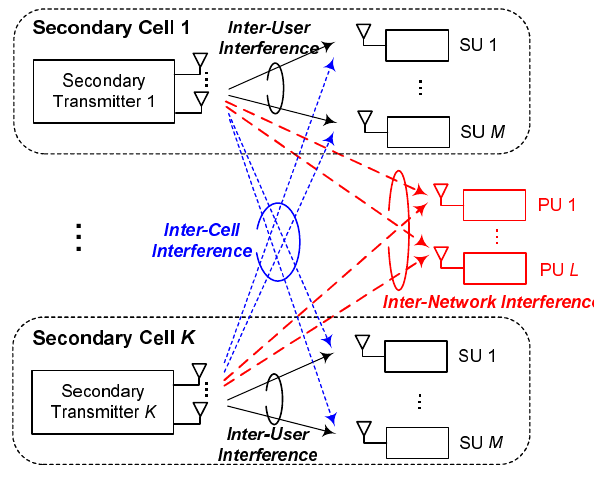
Figure 1. The system